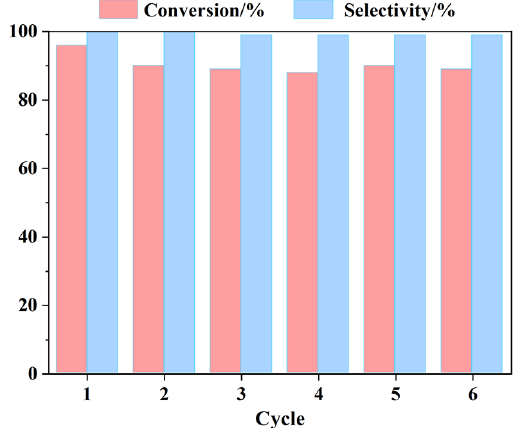
Figure 6. Reusability of Ce 0.7 Zr 0.3 O 2 catalyst.